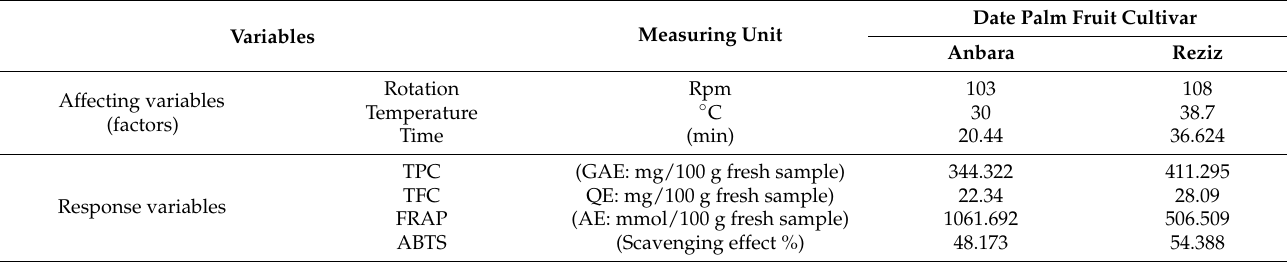
Table 3. The ideal predicted values of the factors (rotation, temperature, and time) to obtain the maximum responses (TPC, TFC, FRAP, and ABTS) for each of the date palm fruit cultivars (Anbara and Reziz) according to the surface plot analysis (see Figures